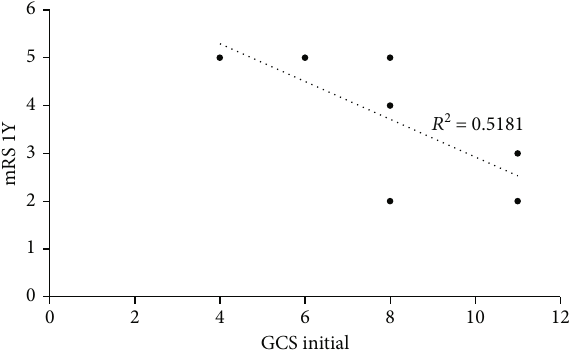
Figure 3: Correlation analysis of 1-year mRS and initial GCS